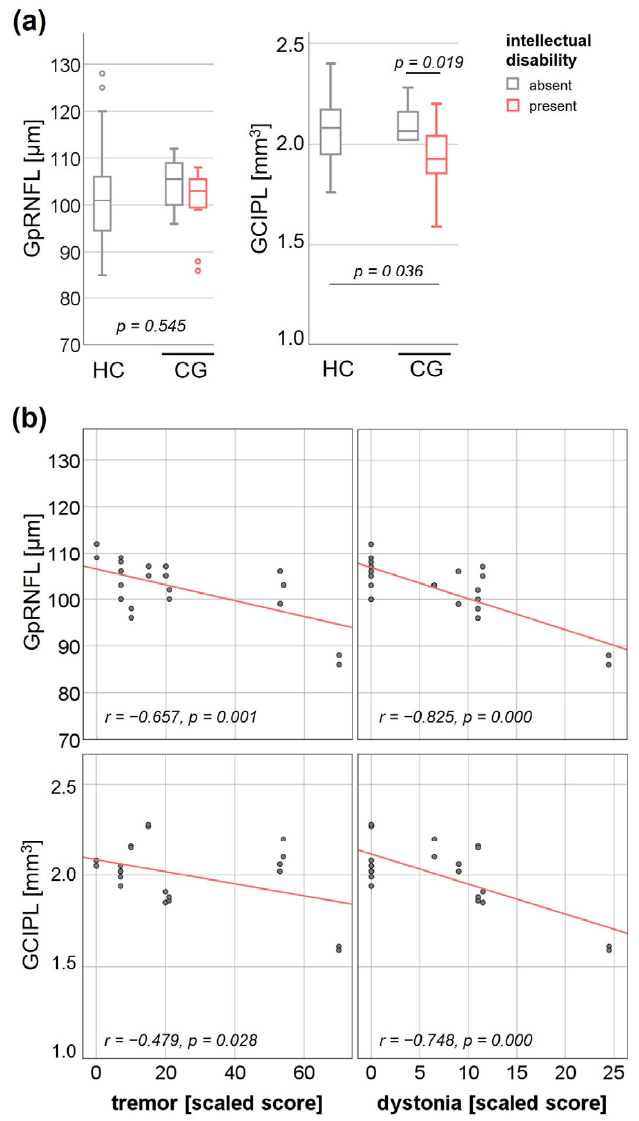
Figure 1. Effect of clinical outcome on global peripapillary retinal nerve fibre layer (GpRNFL) thickness and combined ganglion cell and inner plexiform layer (GCIPL) volume. ( a ) Interaction effect of diagnosis (HC; healthy controls, CG; classical galactosemia) and intellectual outcome on GpRNFL thickness and GCIPL volume. ( b ) Association of GpRNFL thickness and GCIPL volume with the Fahn ‐ Tolosa ‐ Marin Clinical Rating Scale scores for tremor and the Fahn ‐ Marsden Rating Scale scores for dystonia.